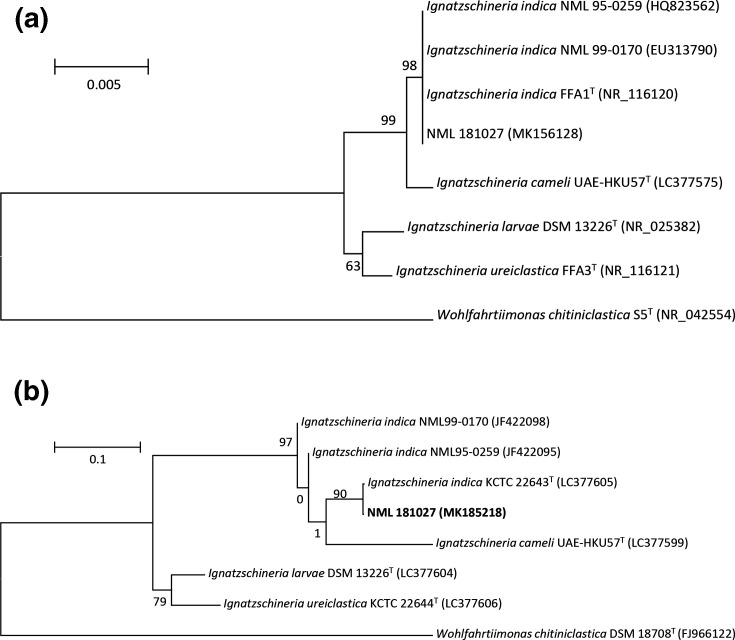
Phylogenetic consensus trees based on nearly full-length 16S rRNA gene sequences (a) or partial gyrB sequences (b) for the patient isolate NML 181027 and two historical NML isolates. Alignment done using Clustal W (default settings) and the neighbour-joining (1000 replicates) algorithm found in mega 6.06. A type strain of
Wohlfahrtiimonas chitiniclastica
 is used as an unrelated outgroup. Scale infers 0.005 (16S) and 0.1 (gyrB) substitutions per nucleotide position.